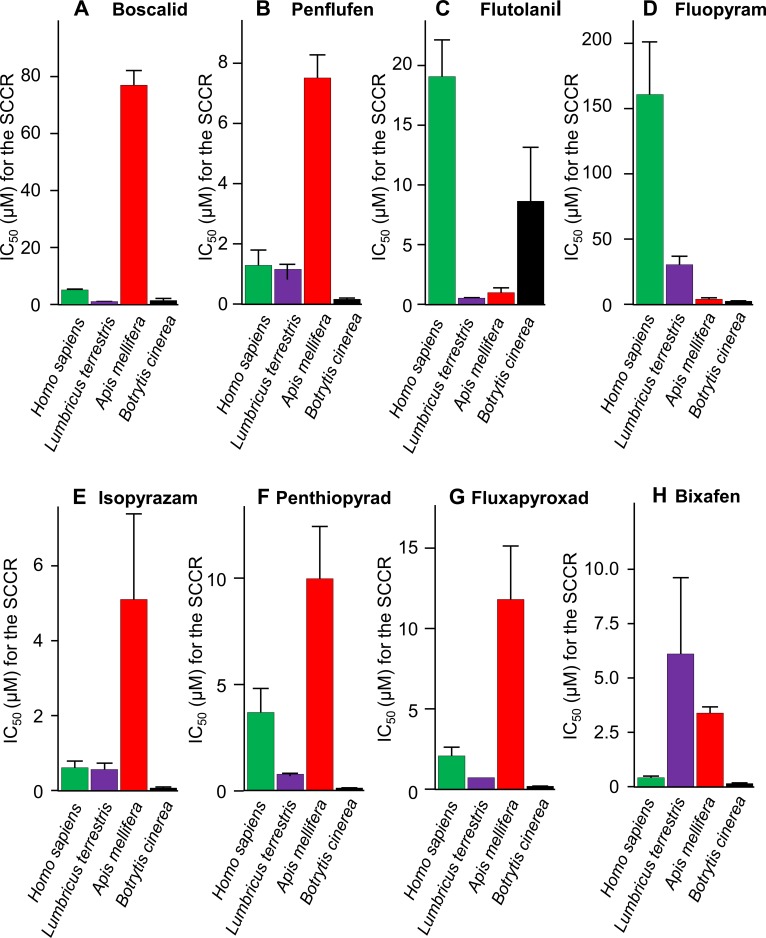
IC50 values of SDHIs on the succinate cytochrome c reductase of Homo sapiens, Lombricus terrestris, Apis mellifera, and Botrytis cinerea.A-H, IC50 (n ≥ 3) of boscalid (A), penflufen (B), flutolanil (C), fluopyram (D), isopyrazam (E), penthiopyrad (F), fluxapyroxad (G), and bixafen (H) on the succinate cytochrome c reductase of Homo sapiens (green), Lumbricus terrestris (purple), Apis mellifera (red), and Botrytis cinerea (black). Note the variable Y scales. SCCR, succinate cytochrome c reductase.